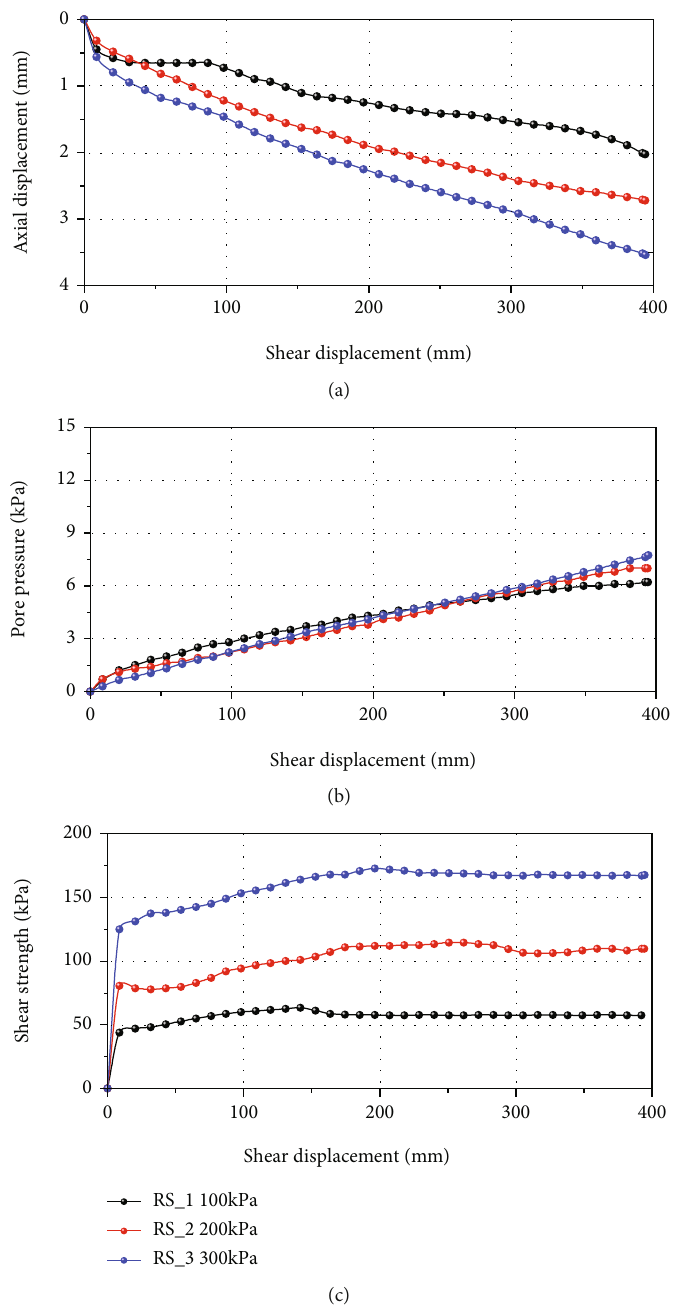
Figure 3: Results of ring shear tests with a shearing rate of